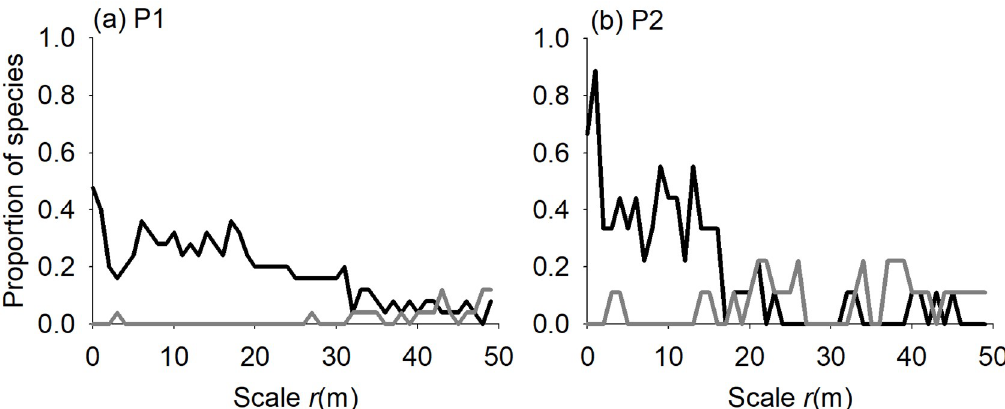
Figure 2. Significant conspecific associations analyzed by the univariate pair-correlation function g 11 ( r ) from 199 Monte Carlo simulations under the null models of CSR at P1 ( a ) and IPP at P2 ( b ) at p values ≤ 0.05. Black lines indicate aggregation, grey lines indicate regularity.